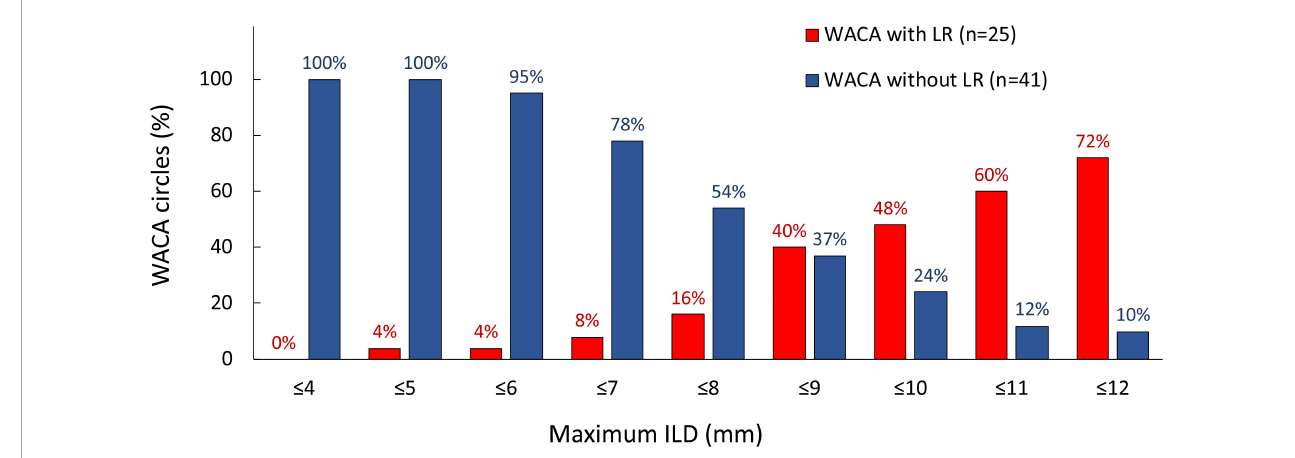
FIGURE4 Distribution of the maximum ILD according to the 3-month isolation status of WACA circles. On the cut-off analysis, a maximum ILD of > 8.0 mm showed significant predictive value for the late WACA reconnection, with sensitivity 84% and specificity 46%. In > 95% of isolated WACA circles the maximum ILD was < 6 mm, while > 40% of WACA circles with late reconnection had the maximum ILD > 8 mm. All abbreviations as in previous